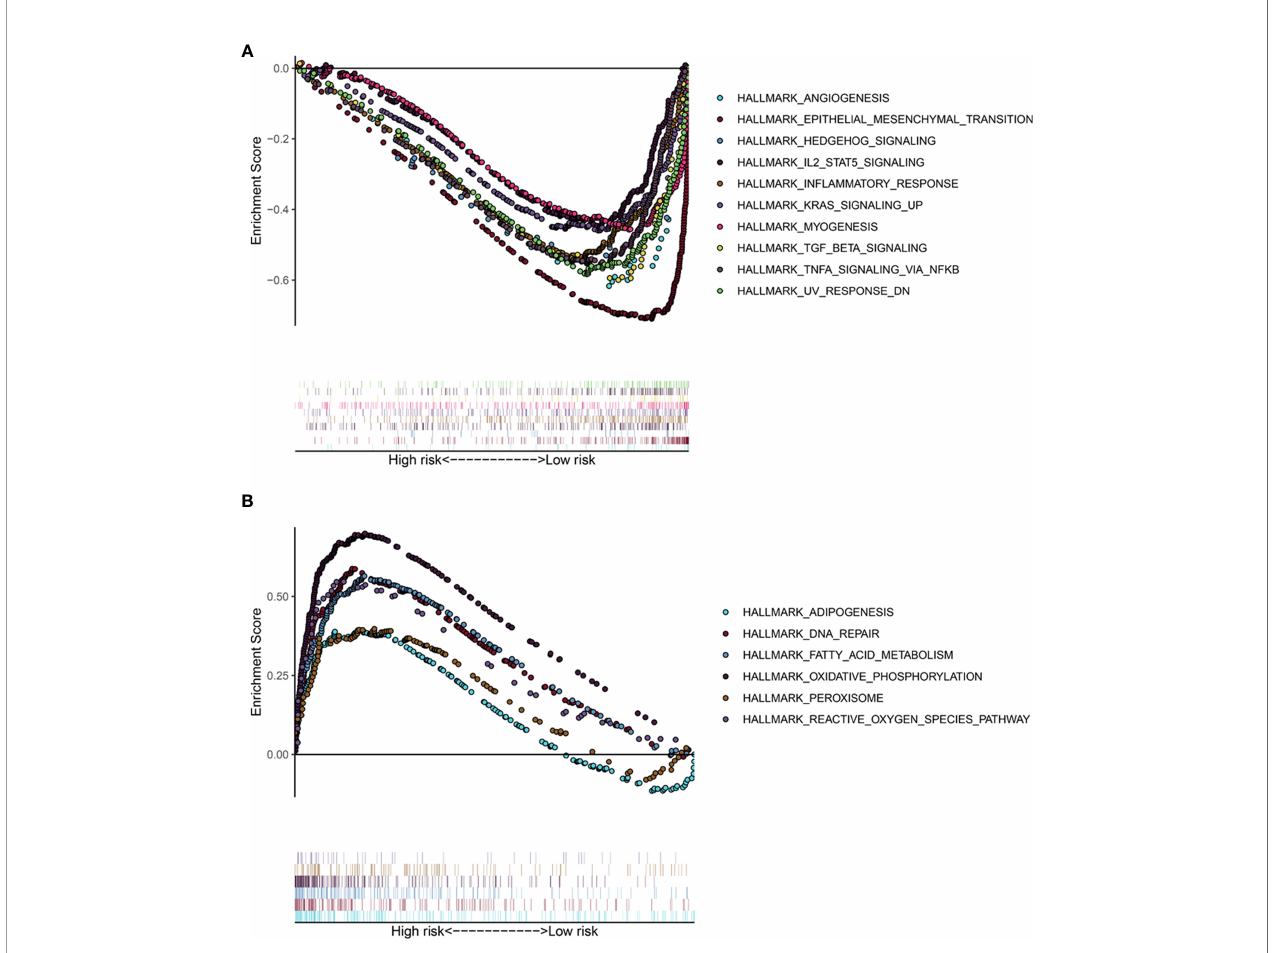
FIGURE 8 | The gene set enrichment analysis (GSEA) of ADAMTS9. (A) GSEA showed that the samples with high ADAMTS9 expression. The gene sets with P < 0.05 and FDR < 0.25 were regarded as signi fi cantly enriched gene sets. (B) GSEA showed that the samples with low ADAMTS9 expression. The gene sets with P < 0.05 and FDR < 0.25 were regarded as signi fi cantly enriched gene sets. FDR, false discovery